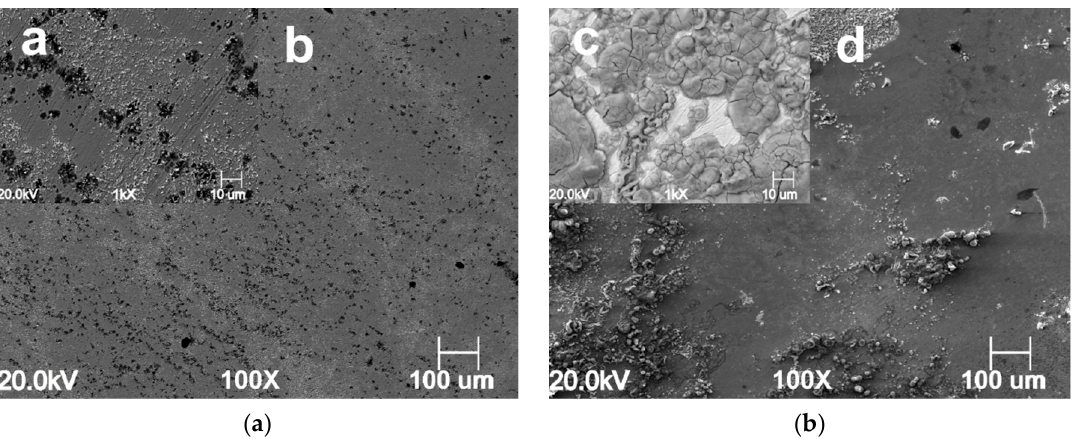
Figure 8. SEM images of the N80 carbon steel surface morphology after 24 h of immersion in the uninhibited (( a ) a lower and b higher magnification) and inhibited (( b ) c lower and d higher magnification) solution at 25 °C and P CO 2 = 20 bar CO 2 .